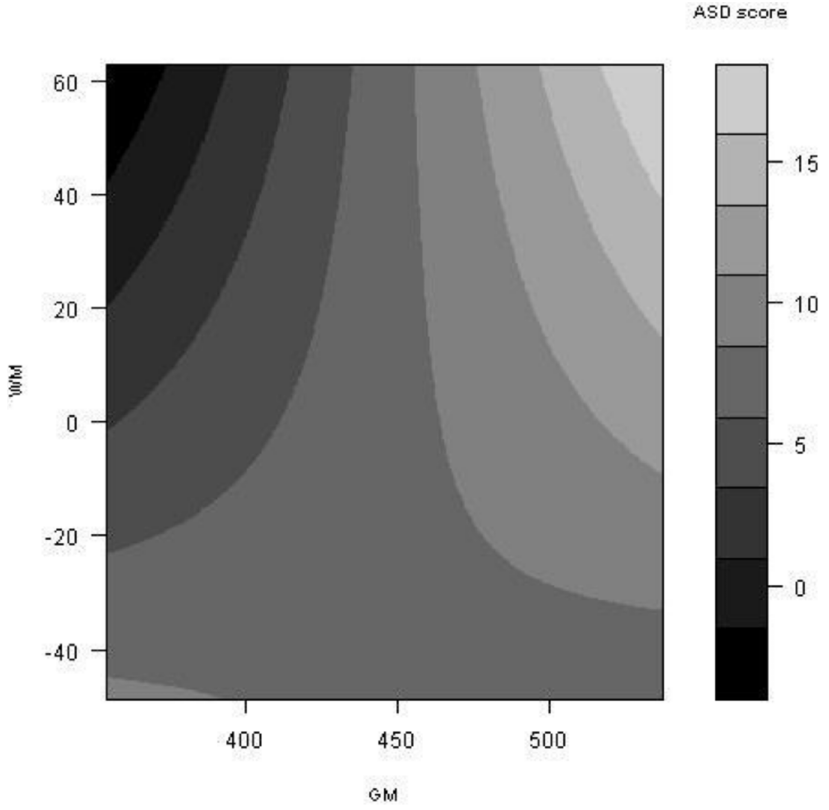
Figure 3. ASD score contour graph for the interaction between WM, GM and ASD scores. The best mixed effects model was converted into a function in R which allowed ASD scores to be extrapolated for a range of GM and WM volumes (see Methods for full description). The best mixed effects model included GM and WM residual terms (see Methods). Volumes are normalised for total intracranial volume. ASD score refers to an aggregate score from the four Children’s Social and Behavioural Questionnaire (CSBQ) subscales, (1) social interest, (2) social understanding, (3) stereotypy and (4) resistance to change.